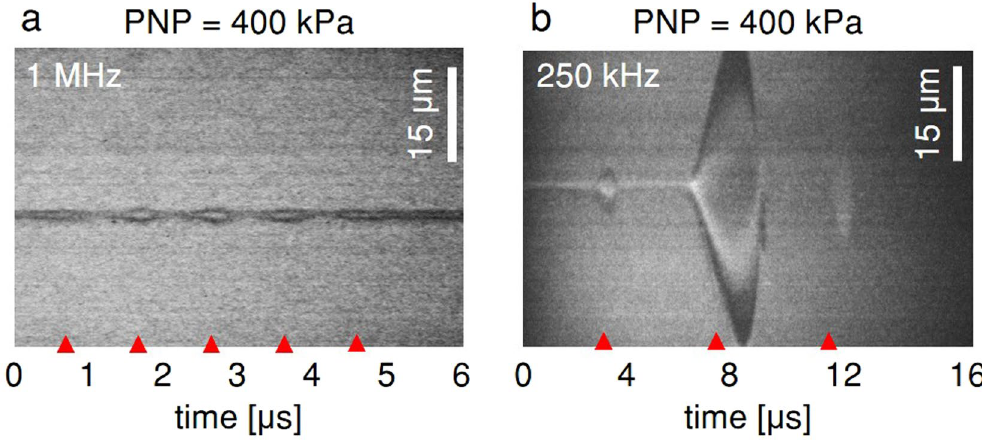
Figure 4. Ultra high-speed camera streak images of oscillating MBs with a resting radius of 1.5 µ m for a peak negative pressure (PNP) of 400 kPa at a center frequency of ( a ) 1 MHz. ( b ) 250